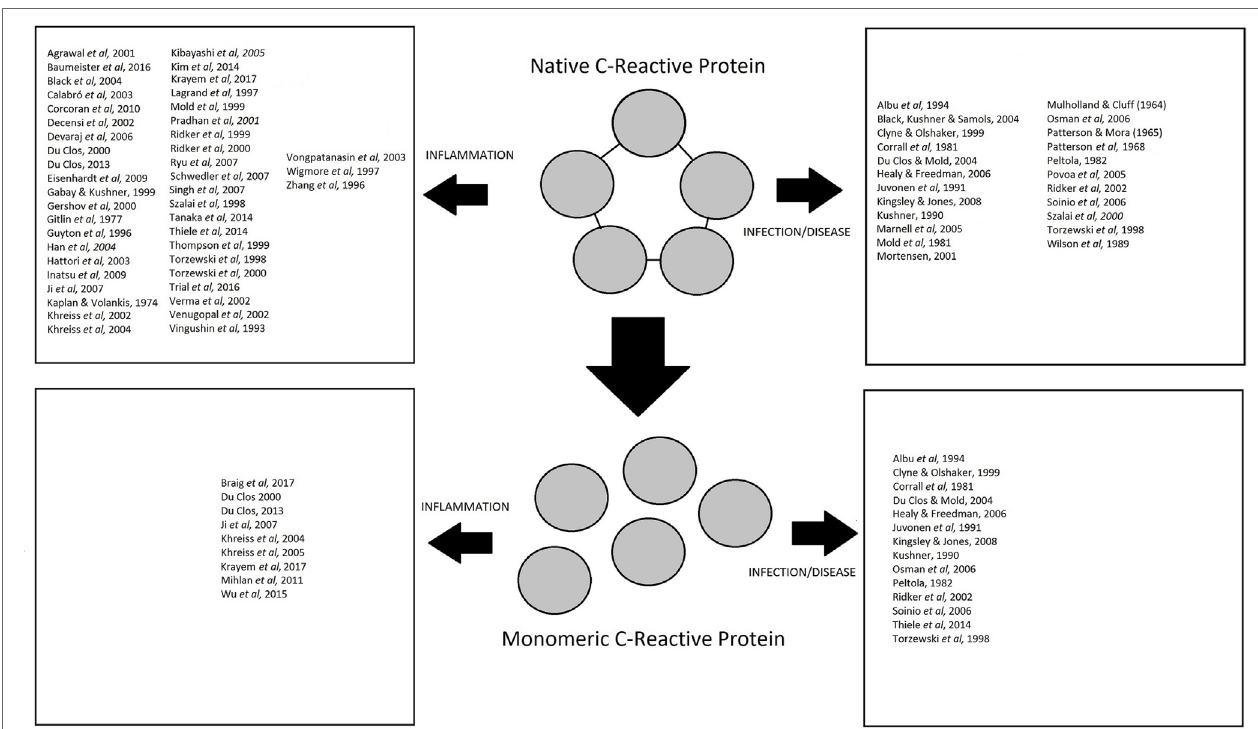
FiGuRe 1 | Summary of studies investigating the role of native C-reactive protein (CRP) and monomeric CRP in inflammation, infection, and